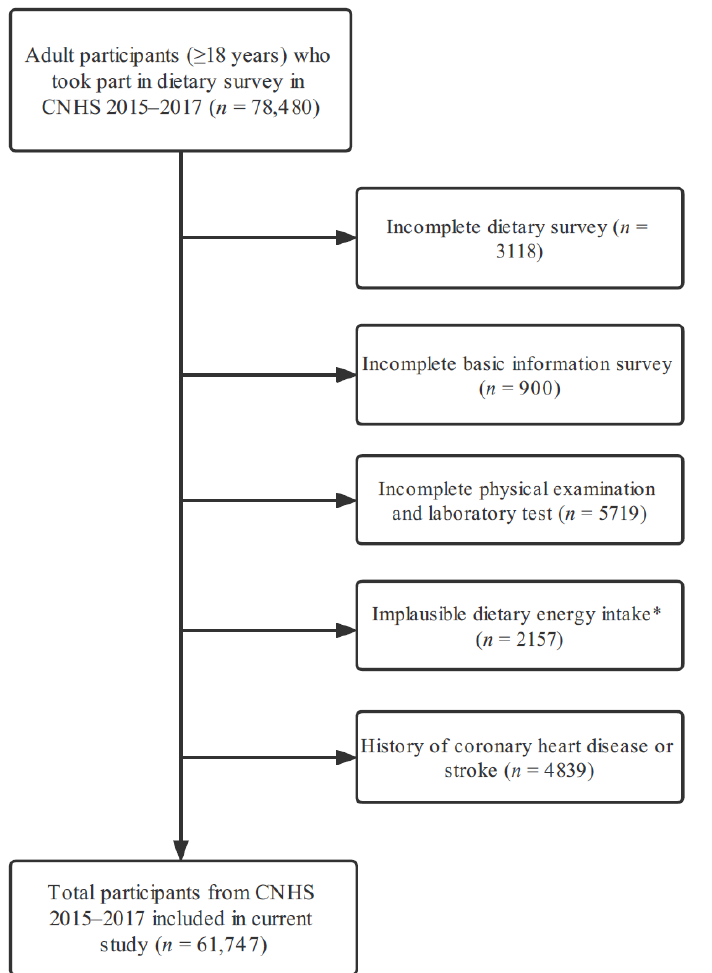
Figure 1. Flow diagram of including eligible participants in current study. * Implausible dietary energy intake was defined as <500 Kcal/day or >5000 Kcal/day.